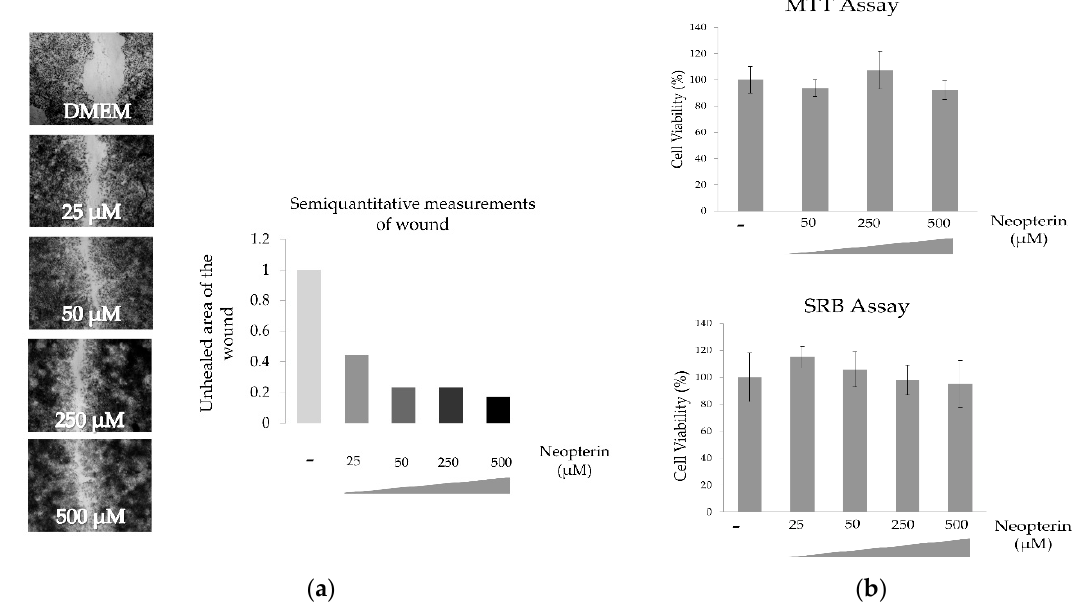
Figure 1. Effect of neopterin on wound healing ( a ) and cytotoxicity ( b ) of HuH-7 cell